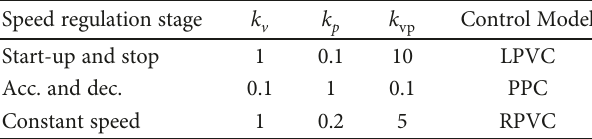
ff erent speed regulation stages. Table 3: k vp at di